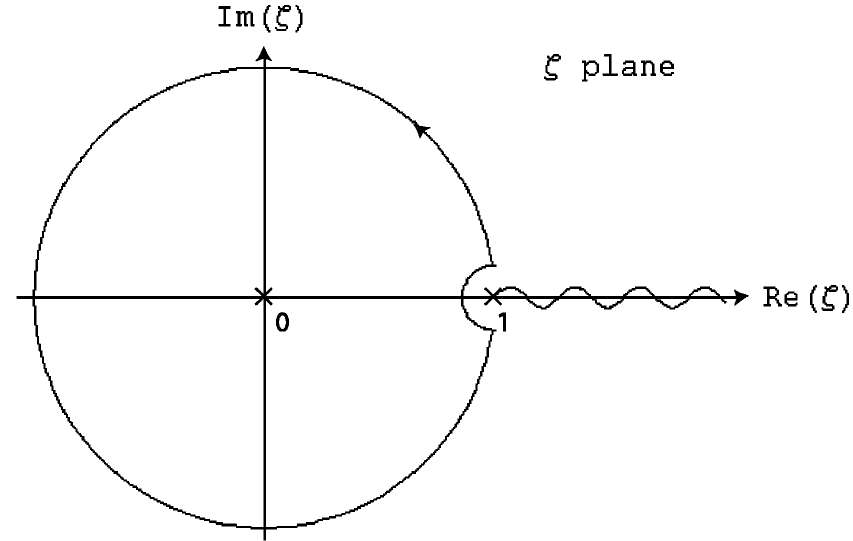
FIG. 1. The contour used for the definition in Eq.